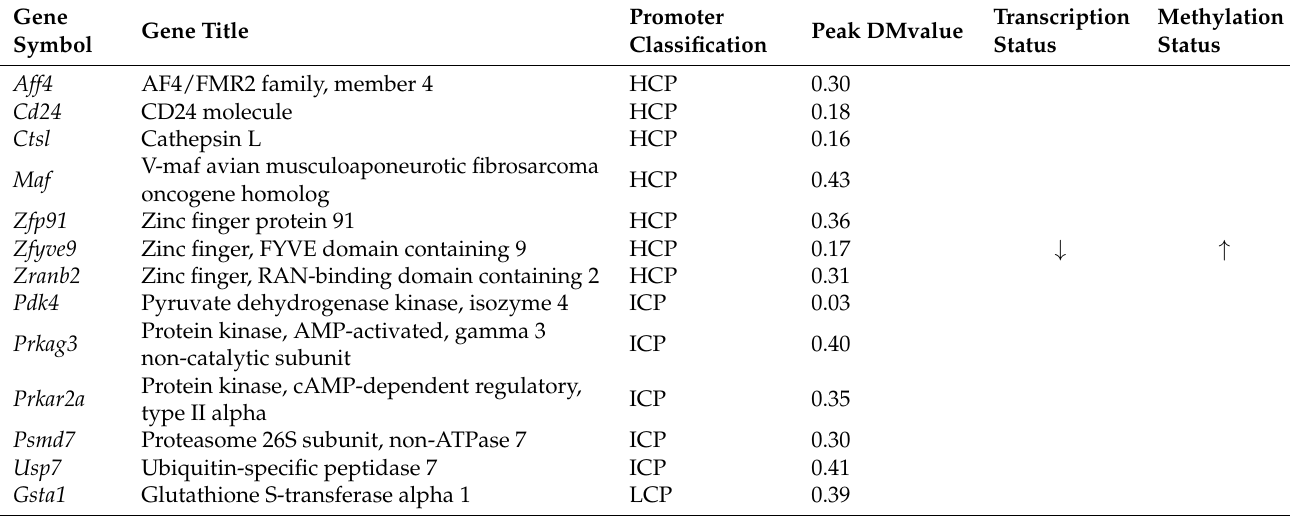
Table 6. Specified genes within the highlighted GO terms (Transcriptome and methylome